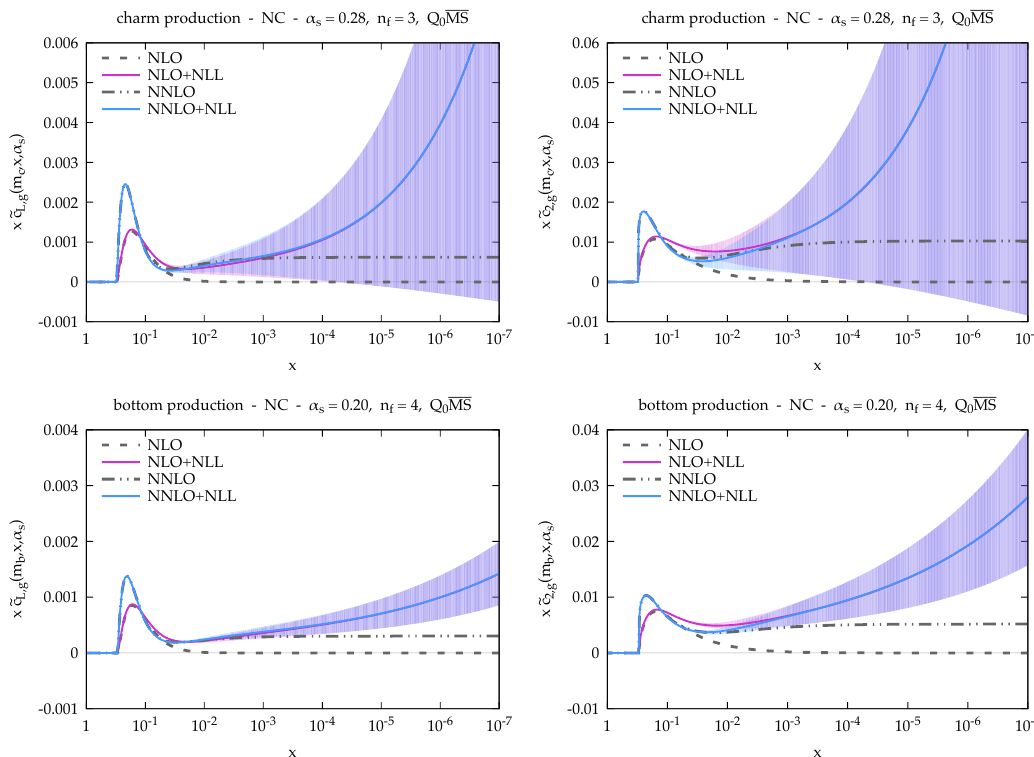
Figure 4 . Same as (cid:12)gure 3, but for the massive coe(cid:14)cient functions c L;g (left) and c 2 ;g (right), e e for both charm production (upper plots) and bottom production (lower plots) in NC. The charm production plots are for n f = 3 and (cid:11) s = 0 : 28, corresponding to Q (cid:24) 2 GeV, slightly above the charm mass m c = 1 : 5 GeV. The bottom production plots are for n f = 4 and (cid:11) s = 0 : 2, corresponding to Q (cid:24) 6 GeV, slightly above the bottom mass m b = 4 : 5 GeV. the bottom mass assumed to be m = 4 : 5 GeV. The number of active (cid:13)avours is set b to be n = 3 for charm production and n = 4 for bottom production, i.e. the f f